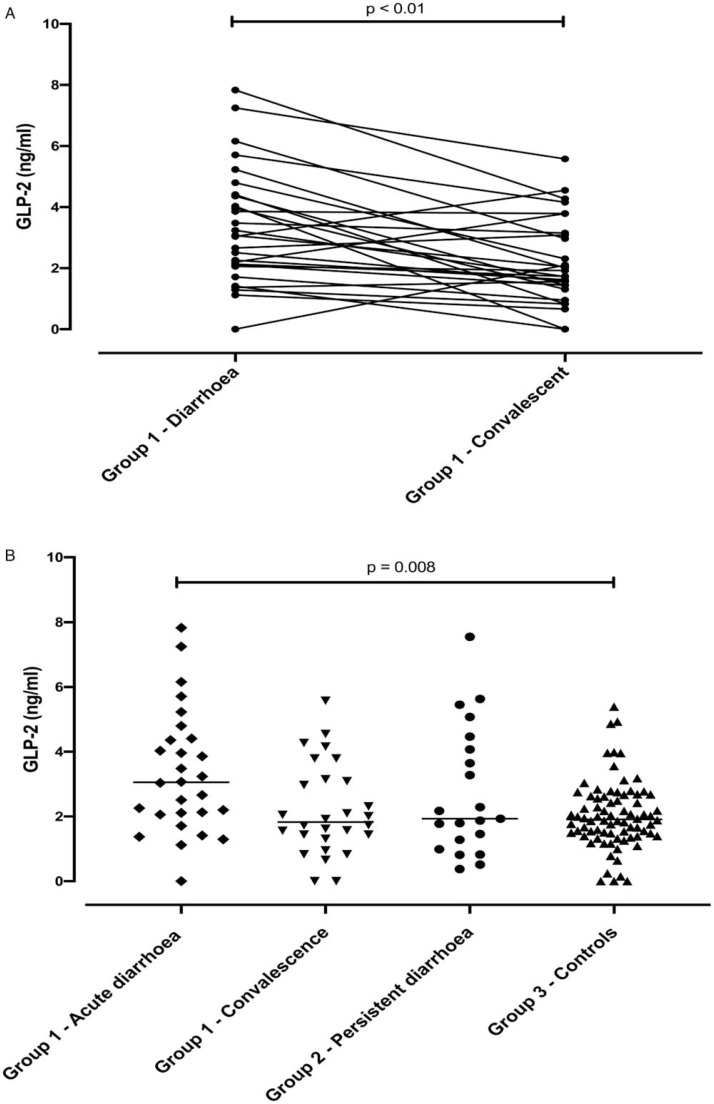
A, GLP-2 levels in children with acute diarrhoea during illness and 3 weeks after their last diarrhoea episode. B, GLP-2 levels in acute and persistent diarrhoea compared to controls. GLP-2 = glucagon-like peptide 2.